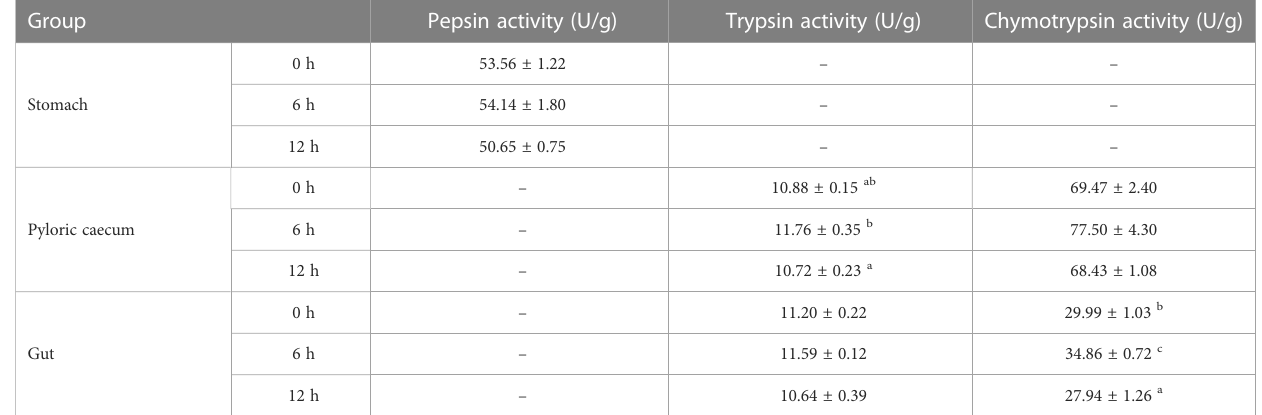
TABLE 2 Protease activities of each gastrointestinal tissue of pond-cultured Japanese fl ounder (Fresh weight). Group